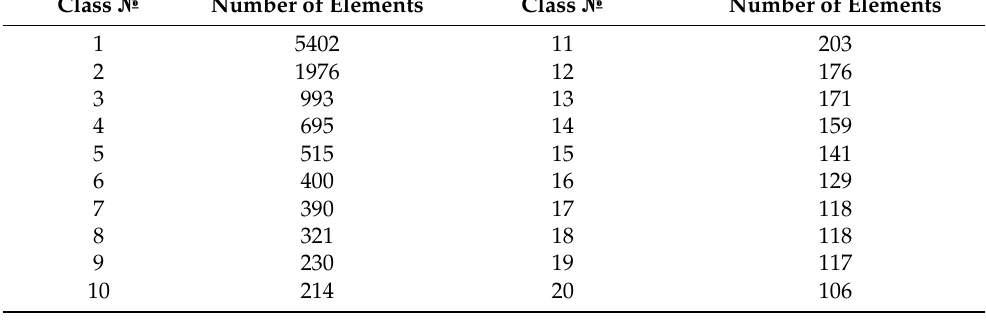
Table 1. Numbers of elements in the created classes of C. annuum promoters.